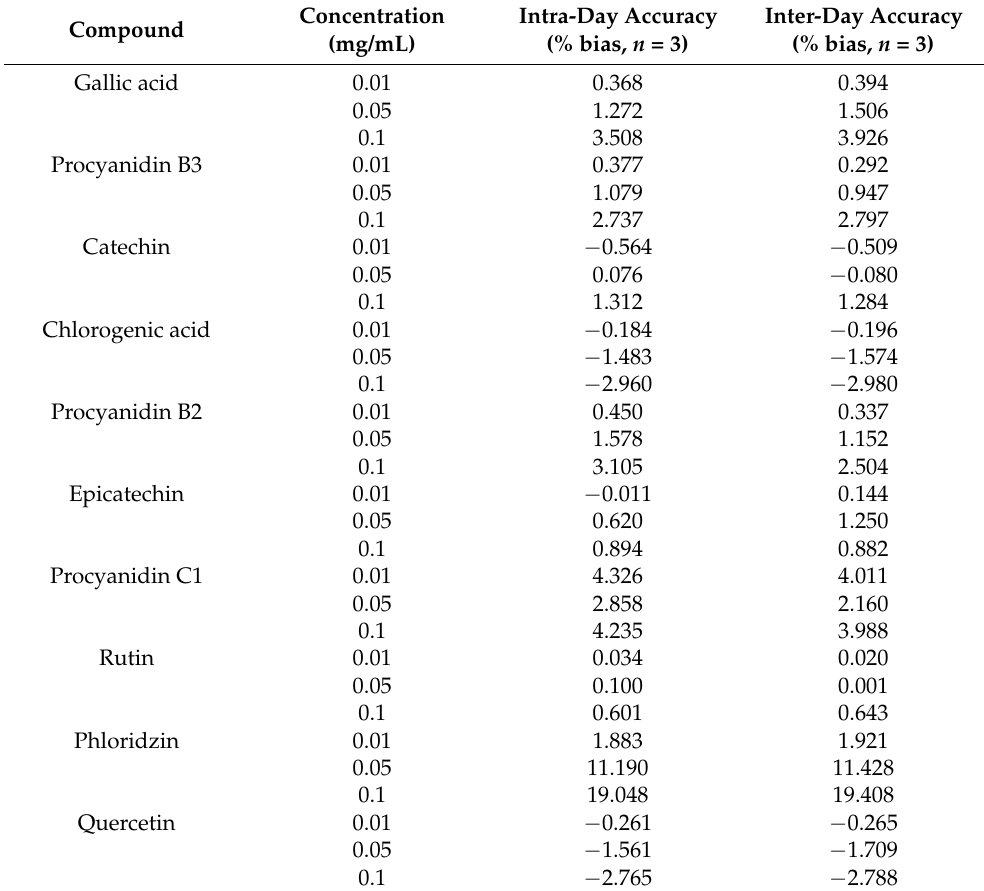
Table 4. Intra-day and inter-day accuracy of the representative compounds of Annurca apple polyphenolic